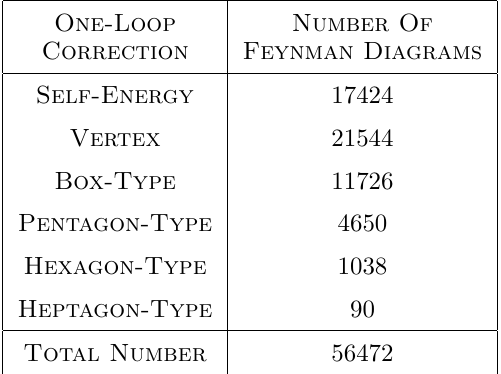
e + (cid:23) e (cid:22) (cid:0) (cid:22) (cid:23) (cid:22) b (cid:22) b(cid:23) (cid:28) (cid:22) (cid:23) (cid:28) !